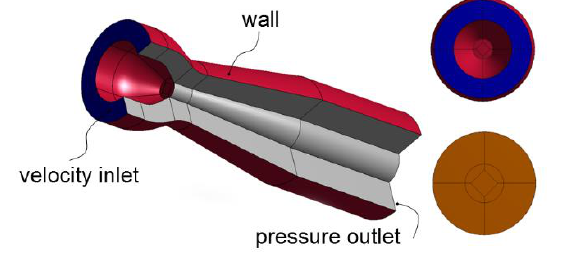
Fig. 6. Boundary conditions and decomposition of the flow domain